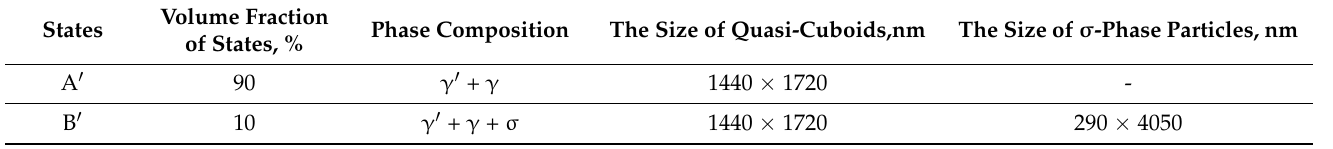
Table 3. Structural phase states and quantitative data of the alloy after DC and annealing.